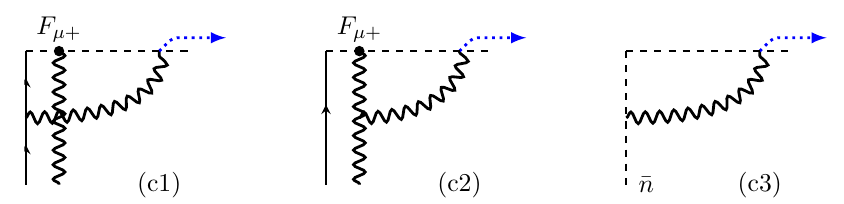
Figure 1 . Diagrams (c1) and (c2) produce the collinear divergence in the UV evolution kernels for operator U . The diagrams (c3) produces the corresponding divergence in the LP soft factor. The 2 blue arrows indicate the limits in which in the loop diagram the divergences occur. Divergences cancel in the ratio between the correlator and the soft factor, leaving the remnant logarithms ln( q + / ( − s∂ + )) in eq. (2.14). These logarithms are responsible for the complex part of the